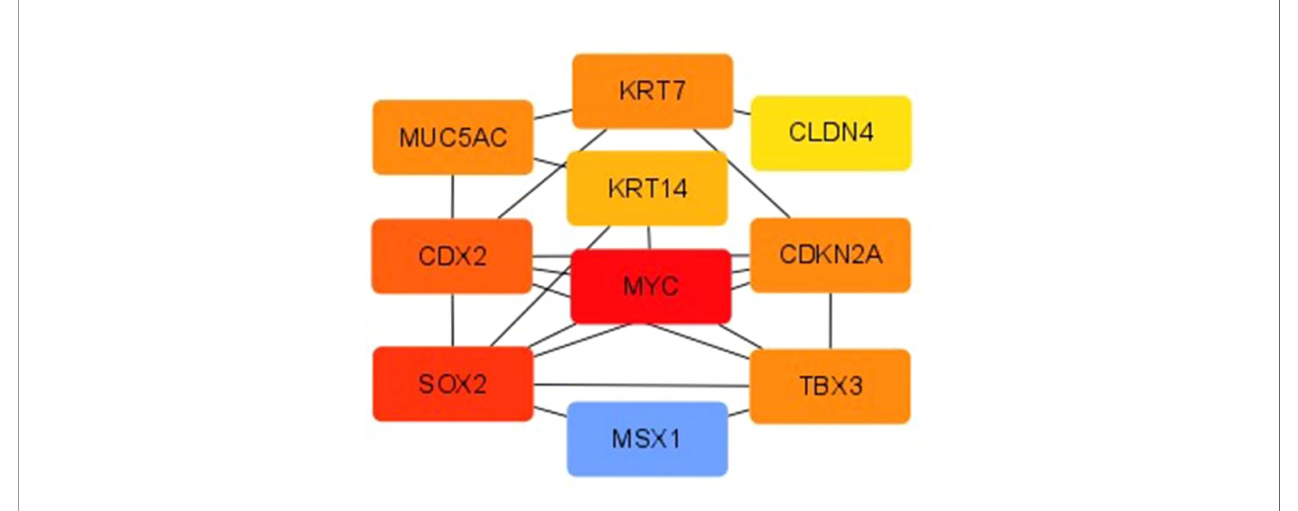
FIGURE 5 | PPI diagram of DEGs.